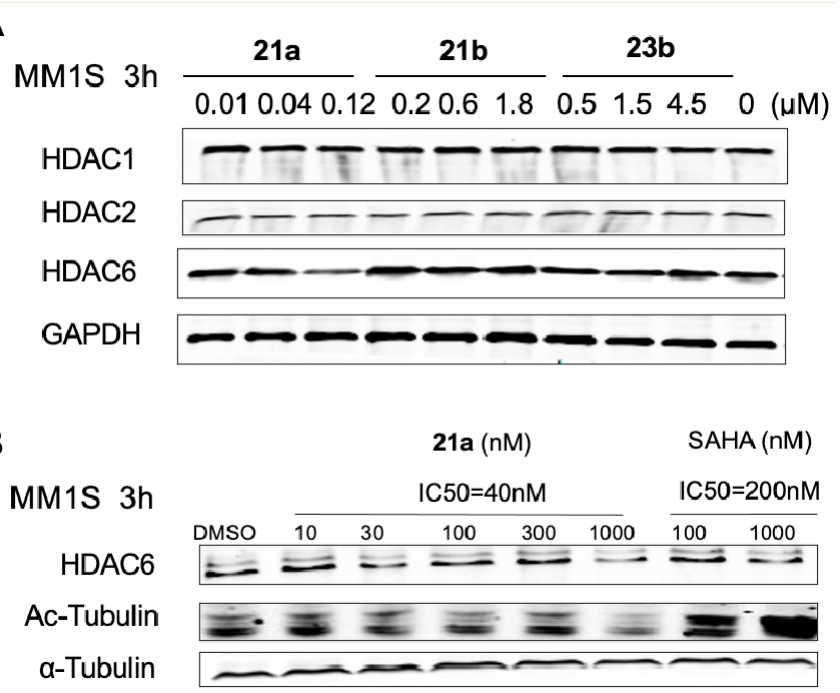
Figure 4. Characterization of HDAC degradation. ( A ) Immunoblot of HDAC1, HDAC3, and HDAC6 following 3 h of incubation with DMSO, 21a , 21b or 23a in MM.1S cells. ( B ) Degradation of HDAC6 in MM.1S cells treated by 21a or SAHA for 3